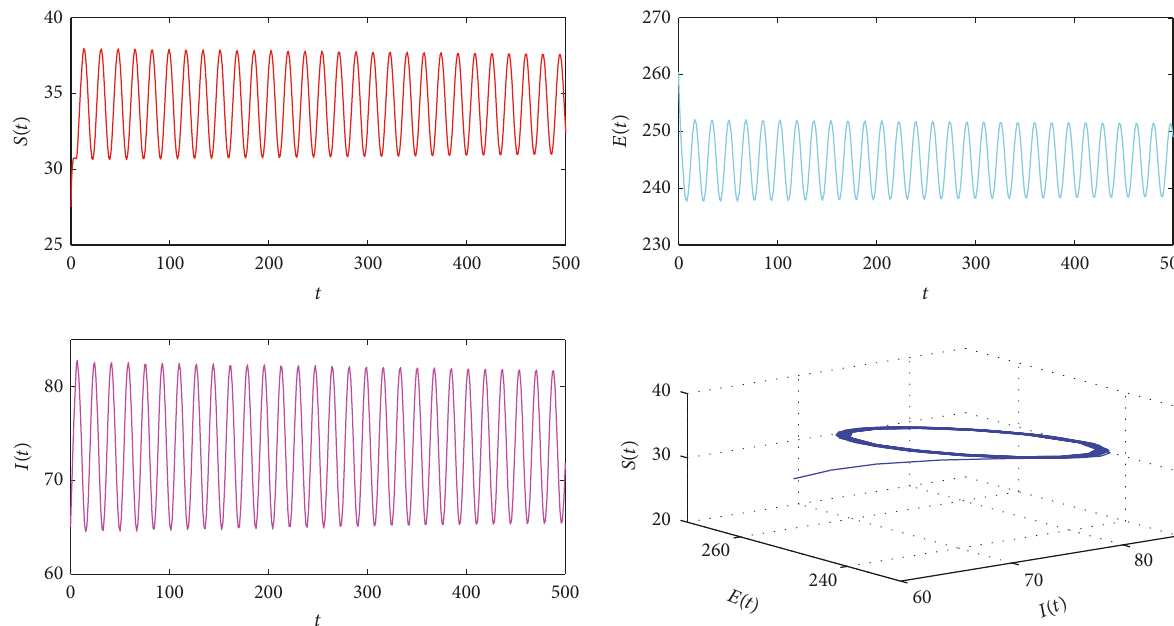
Figure 3: 𝑃 ∗ becomes unstable and a Hopf bifurcation occurs when 𝜏 = 5.485 > 𝜏 0 = 5.1686 with initial values “27.5, 260.5, 65.”